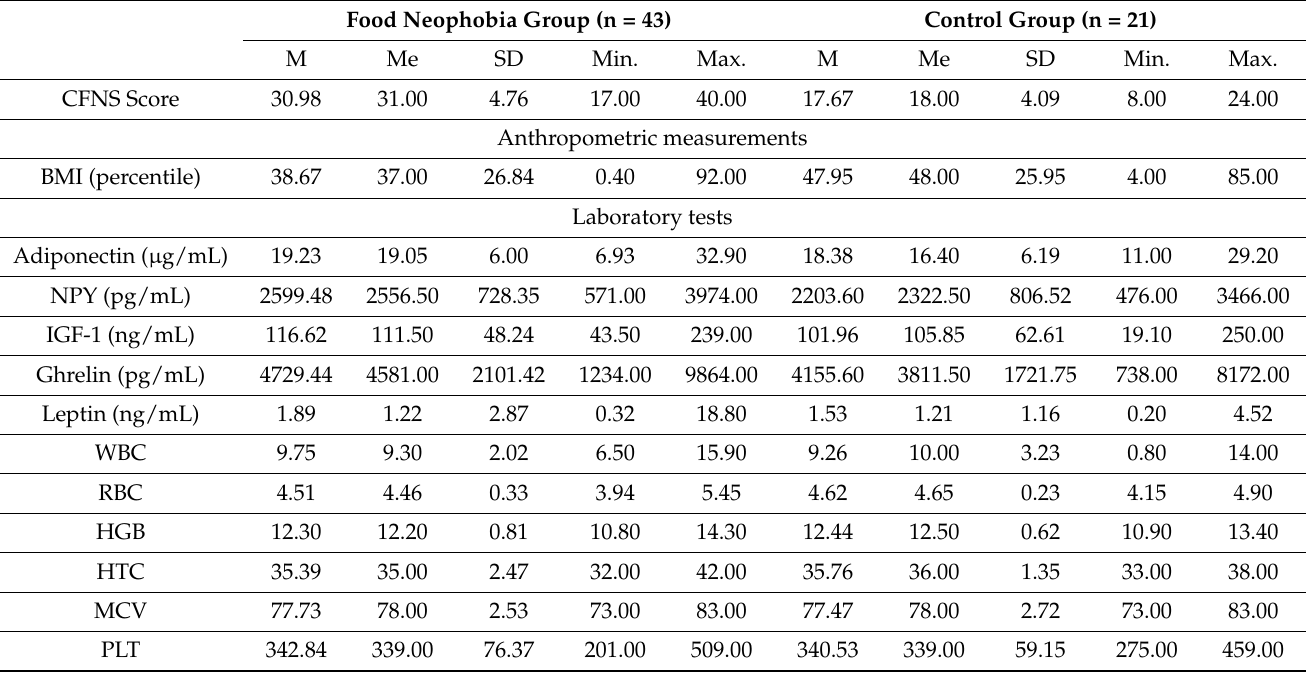
Table 1. Descriptive characteristic of food neophobia and control group.